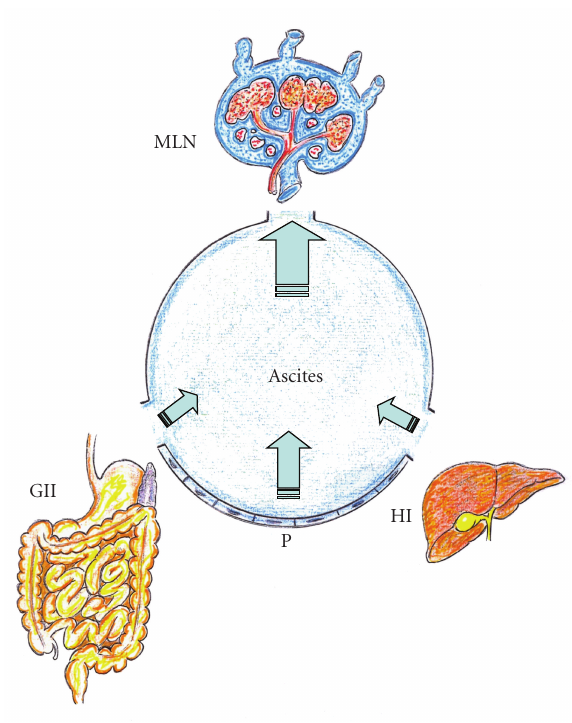
Figure 3: Acute-on-chronic splanchnic inflammation. Worsening of the portal hypertensive syndrome is associated with ascites. The ascitic fluid increases the lymphatic mesenteric flow as well as the lymphatic capillary stasis in the interstitium, which in turn would worsen the splanchnic inflammatory response. GII: Gastrointestinal interstitium; HI: Hepatic interstitium; MLN: Mesenteric lymph nodes; P: peritoneum.